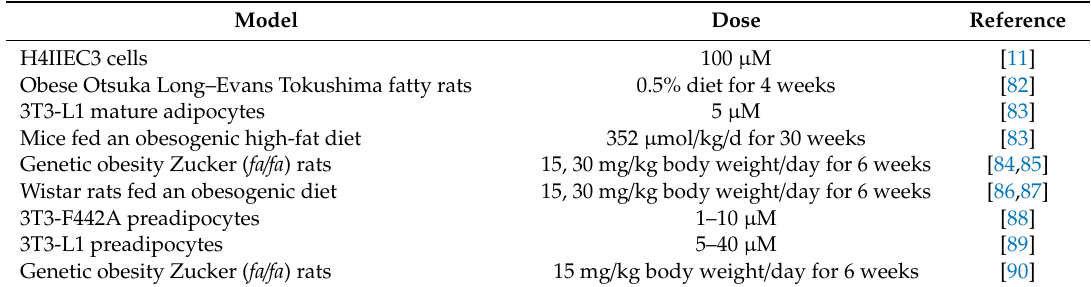
Table 4. Model and dose of lipid-lowering activity of